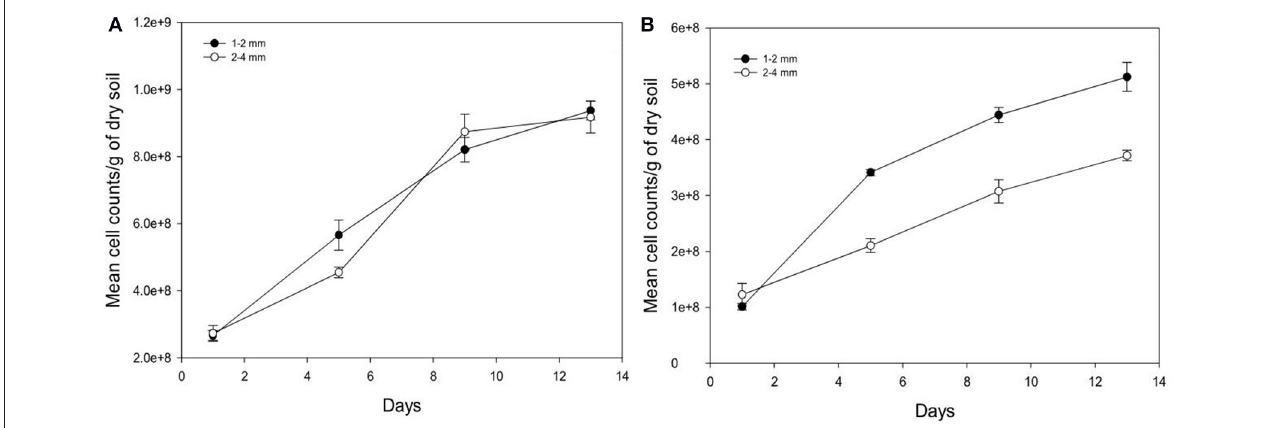
FIGURE 6 | Change in the number of cells per gram soil with time after inoculation with P. fluorescens (A) and B. subtilis (B) detected at different sampling time in soil of aggregate size classes 1–2mm (•) and 2–4mm ( ◦ ). Data are means ± SE ( n = 3).